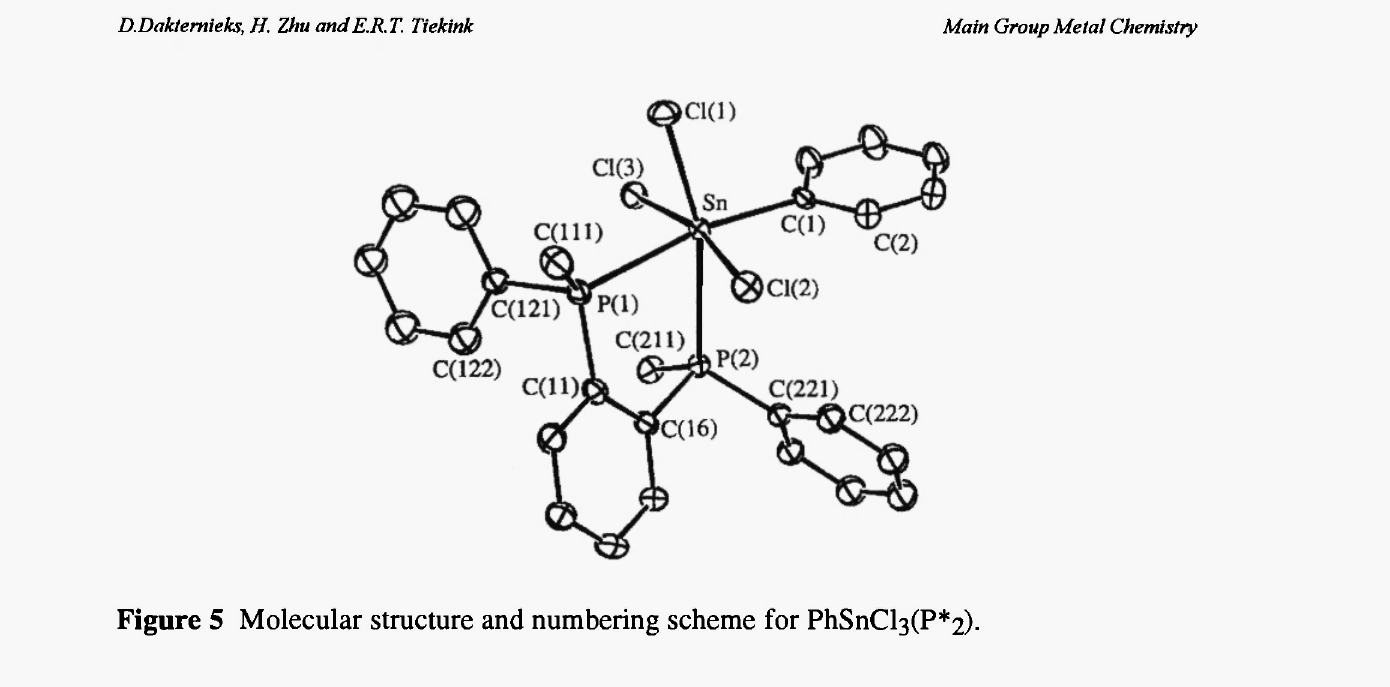
Figure 5 Molecular structure and numbering scheme for